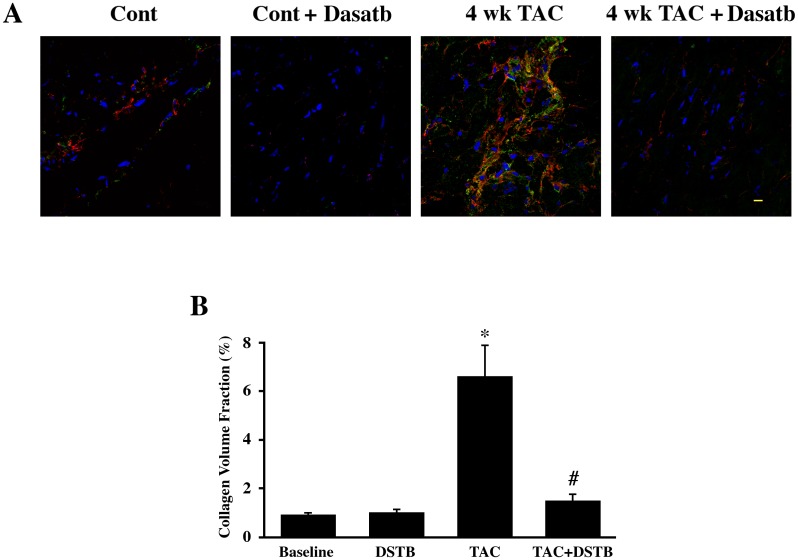
Reduction of pressure overload induced fibronectin and collagen accumulation and maladaptive ventricular changes in dasatinib treated mice.Mice were surgically implanted with osmotic mini-pumps to deliver either vehicle or dasatinib (0.44 mg/kg/day). Two days after mini-pump implantation, mice were used either for TAC or sham (Control) surgery. After 4 wk, echocardiography was performed and end points taken. (A) LV sections were stained for fibronectin (red) and collagen-1 (green) using specific antibodies and nuclei using DAPI (blue). Results were confirmed in two additional mice samples (n = 3) for each group. Scale bar, 10 μm. (B) LV sections for each mice group (n = 6) were stained for collagen using picrosirius red and the collagen volume fraction was calculated. *p< 0.05 vs. Control; #p< 0.05 vs. TAC. (C) LV/bodyweight (mg/g) ratio was calculated for all mice after sacrifice (n = 6 for each group) and graphed. *p< 0.05 vs. Control; #p< 0.05 vs. TAC.